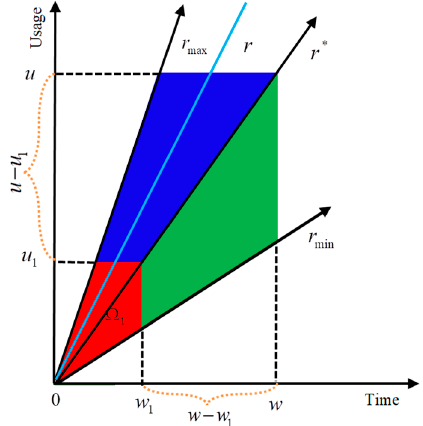
Figure 1. The warranty region description.